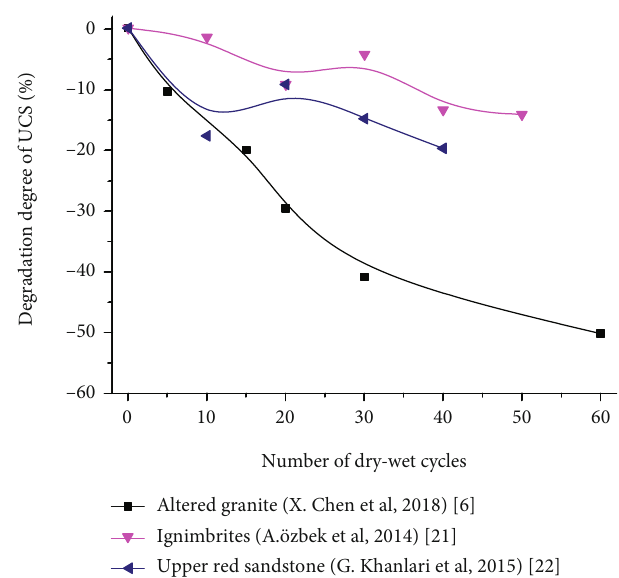
Figure 10: Degradation degree of UCS after long-term dry-wet cycles.